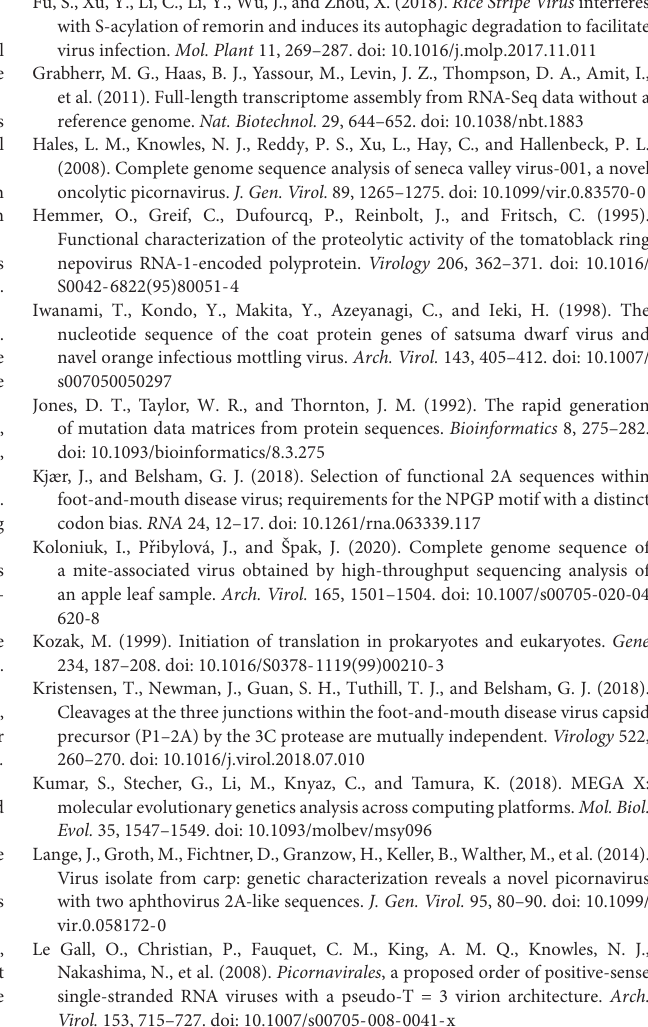
Supplementary Figure 1 | Rice curl dwarf-associated picornavirus (RCDaV) was detected by RT-PCR in symptomatic rice and barnyard grass plants using RCDaV specific primers. Supplementary Figure 2 | Protein 3D structure prediction of rice curl dwarf-associated picornavirus (RCDaV) 3Cpro. (A) Using the structure of HAV Supplementary Figure 3 | Trans -cleavage activities of tag-free rice curl dwarf-associated picornavirus (RCDaV) 3Cpro 1072 − 1325 . (A) Schematic representation of tag-free RCDaV 3Cpro 1072 − 1325 . (B) Substrate Pro 1054 − 1496 -FLAG(S 1261 A) was incubated with MBP-Pro 1054 − 1496 -SUMO-His or tag-free RCDaV 3Cpro 1072 − 1325 in the trans -cleavage assay followed by western blot analysis.